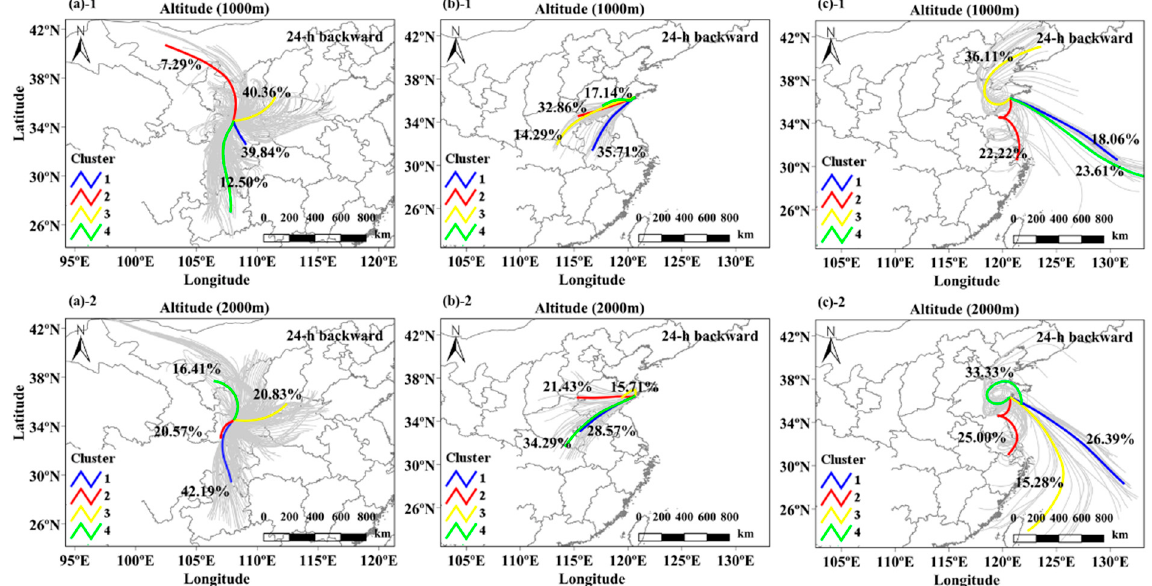
Figure 16. A 24-hour backward trajectory cluster analysis of air masses in Qingdao and Xi’an under con-tinuous precipitation and torrential rain: ( a )-1 continuous precipitation in Xi’an at 1000 m, ( a )-2 continuous precipita-tion in Xi’an at 2000 m, ( b )-1 continuous precipitation in Qingdao at 1000 m, ( b )-2 continuous precipitation in Qingdao at 2000 m, ( c )-1 torrential rain in Qingdao at 1000 m, ( c )-2 torrential rain in Qingdao at 2000 m.